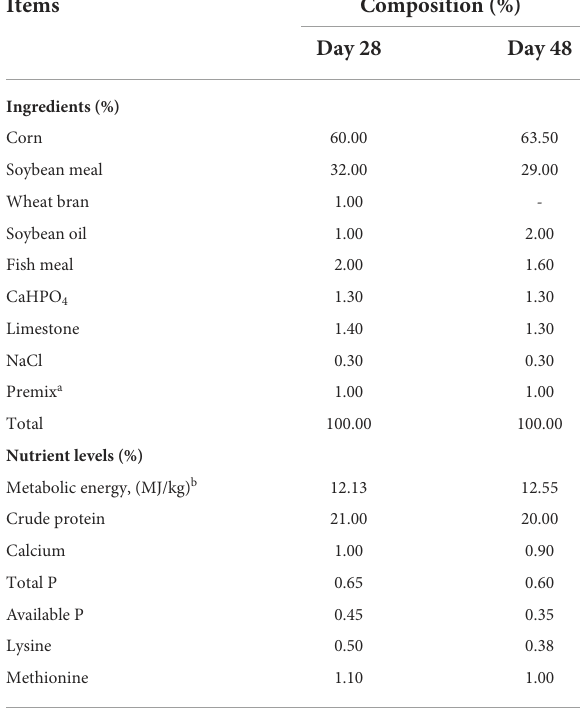
TABLE 1 Ingredient and nutrient levels of the basal diet in each feeding phase for broilers.